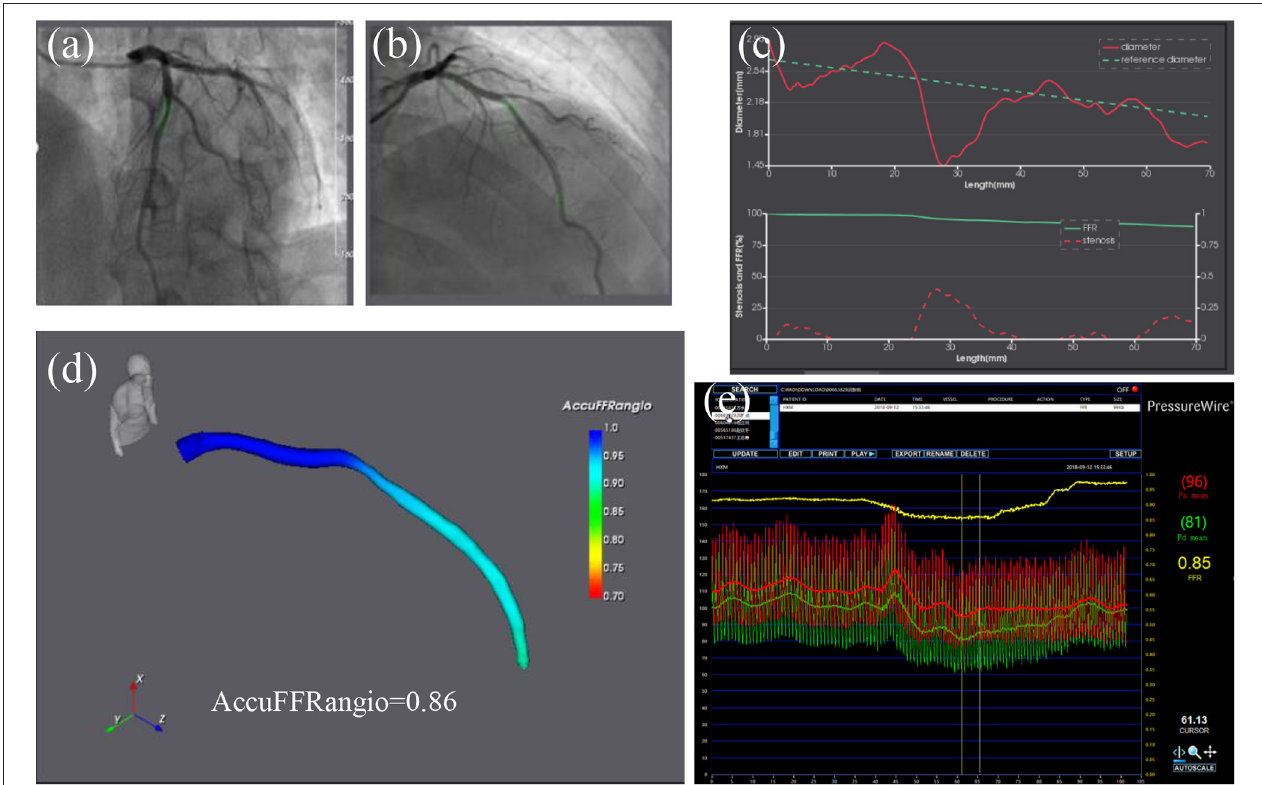
FIGURE 1 | AccuFFRangio analysis of intermediate stenosis of a left anterior descending artery (LAD). (a,b) Coronary angiography images from two different angles of view. (c) The above chart shows the change of lumen diameter (red) along LAD with the computed reference diameter (green); the chart below shows the diameter stenosis (red) and AccuFFRangio pullback (green). (d) Computed AccuFFRangio distribution; the AccuFFRangio value was 0.86. (e) The FFR measured by pressure wire was